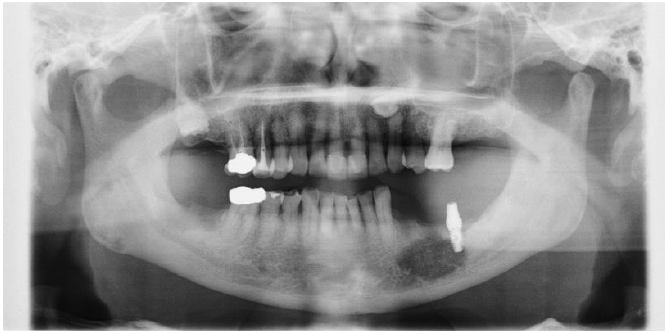
Figure 2. Initial biopsy specimens: representative images of initial gingival biopsy specimens that were interpreted as pemphigus vulgaris. The features presented include gaps in the epithelial basal cells and intracavitary Tzanck cells with no epithelial cell dysplasia. Stain, hematoxylin and eosin (H&E); magnification, original ×200.